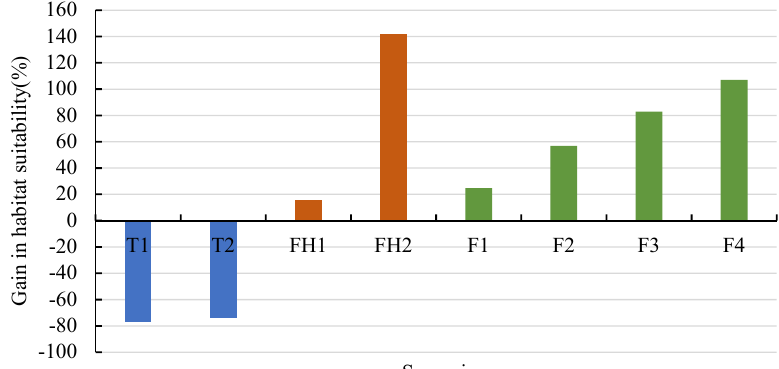
Figure 6. Relative gain (%) in habitat suitability for the great spotted woodpecker ( Dendrocopos major ) at Maoershan Forest Farm, China, compared to the suitable habitat area at beginning of planning horizon with alternative management strategies: timber-oriented management strategy (TMS, scenarios T1 and T2), fixed selection of suitable habitat management strategy (FSSHMS, scenarios FH1 and FH2), and free selection of restricted suitable habitat management strategy (FSRSHMS, scenarios F1 to F4).